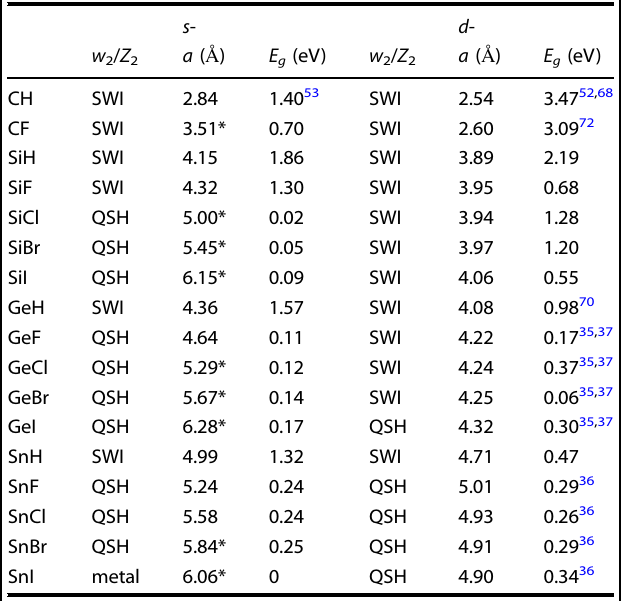
The bandgaps ( E g ) are obtained from fi rst-principles calculations or refer to experiments. w 2 / Z 2 denotes the type of topological states (i.e., the SWI or QSH phase). Star (*) mark energetically unfavorable s -liganded structures, which have much larger (>15%) lattice constants a than its d